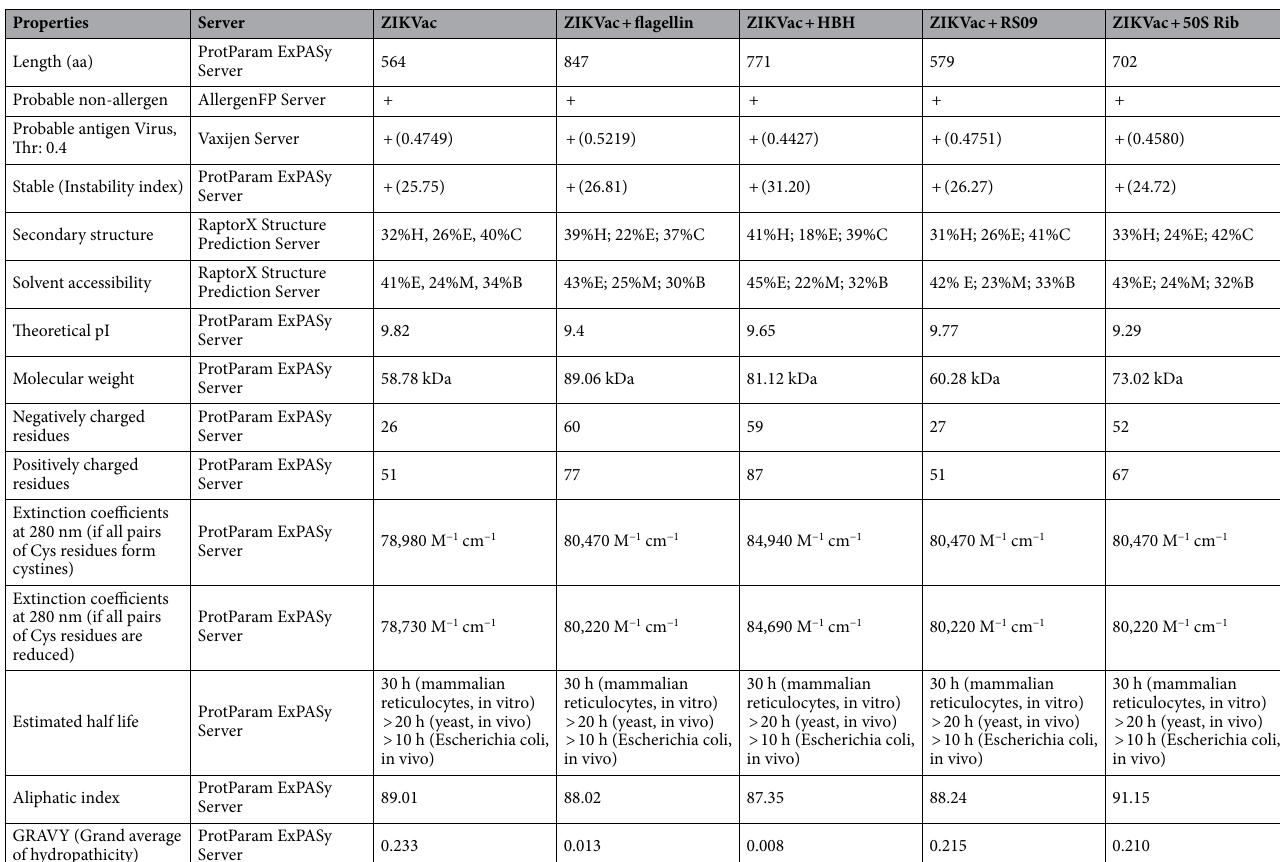
Table 3. Allergenicity, antigenicity and physicochemical parameters of the ZIKVac and with association with the proteinaceous